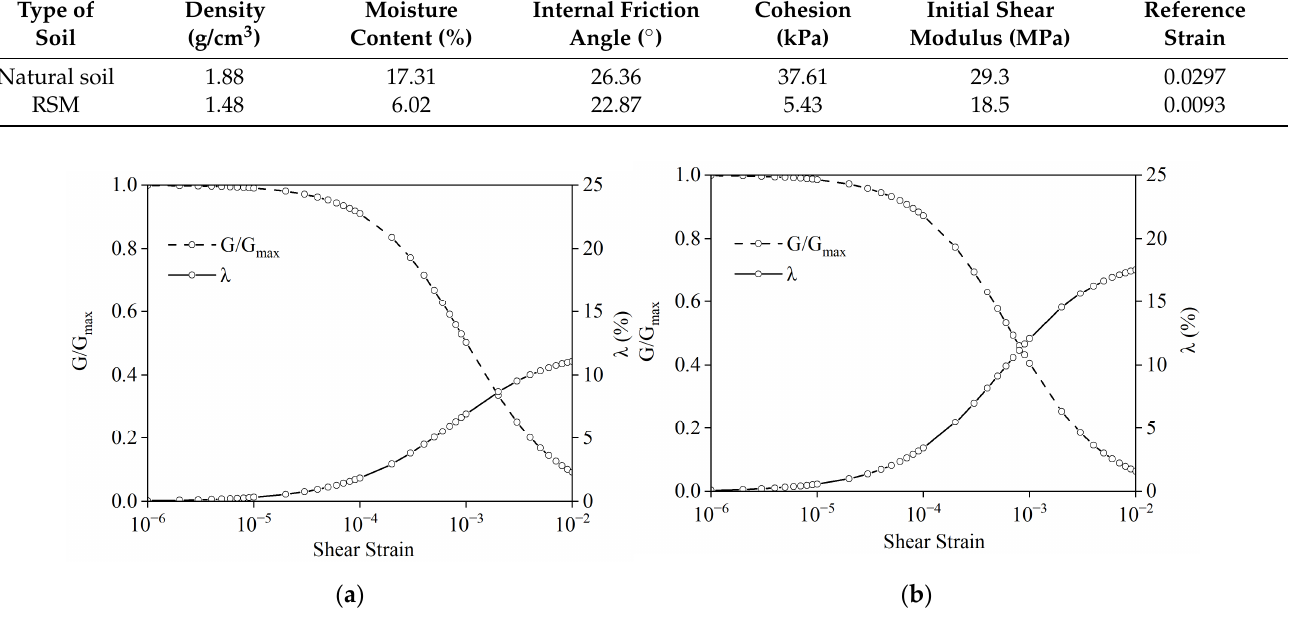
Figure 11. Curve of shear modulus ratio and damping ratio of soil with shear strain: ( a ) natural soil; ( b ) RSM. Table 4. Basic physical and mechanical parameters of